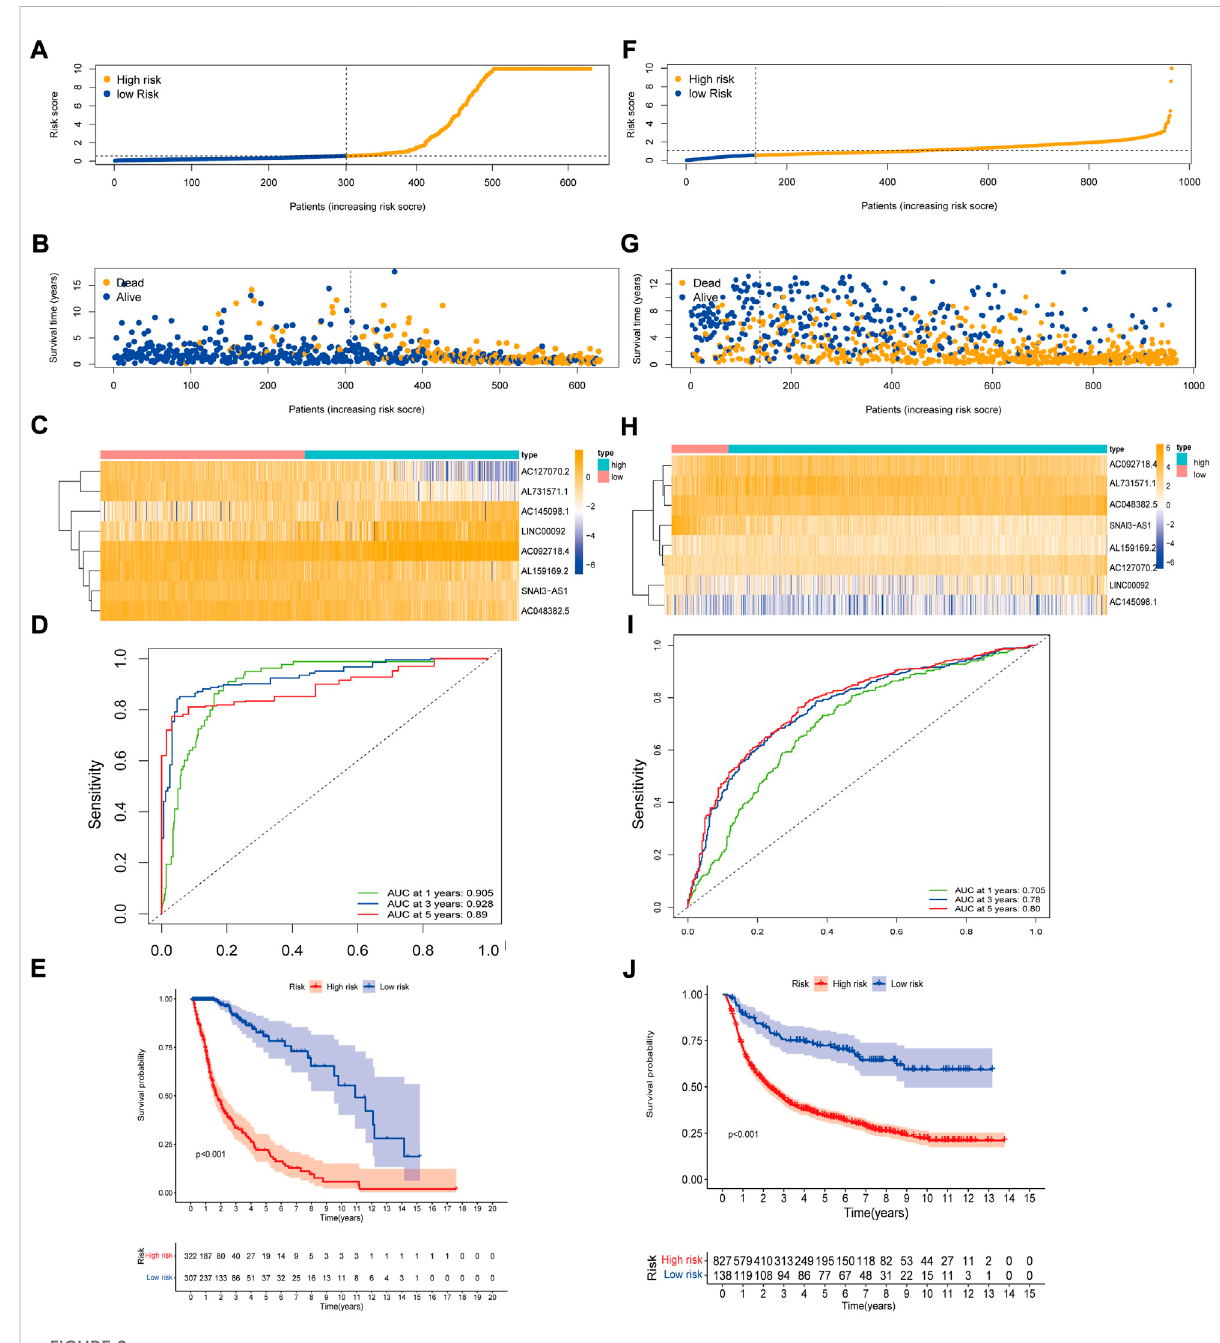
FIGURE 2 Construction and validation of the 8 prognostic m 7 G-related lncRNAs signature for survival prediction. (A) Distribution of RS in TCGA. (B) Survival time and status of patients in TCGA. (C) Heatmap of prognostic m 7 G-related lncRNAs of RS in TCGA. (D) ROC curve for TCGA. (E) KM curve forTCGA. (F) Distribution ofRSinCGGA. (G) SurvivaltimeandstatusofpatientsinCGGA. (H) Heatmapofm 7 G-relatedlncRNAsofRSinCGGA. (I) ROC curve for CGGA. (J) KM curve for